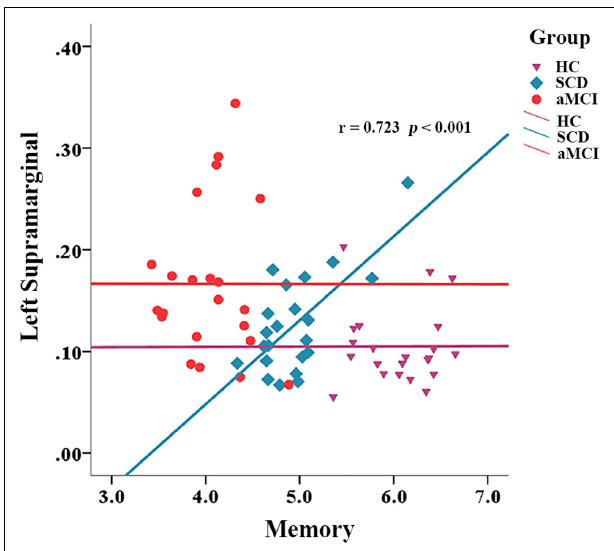
FIGURE 5 | Correlation between network metrics and memory in different